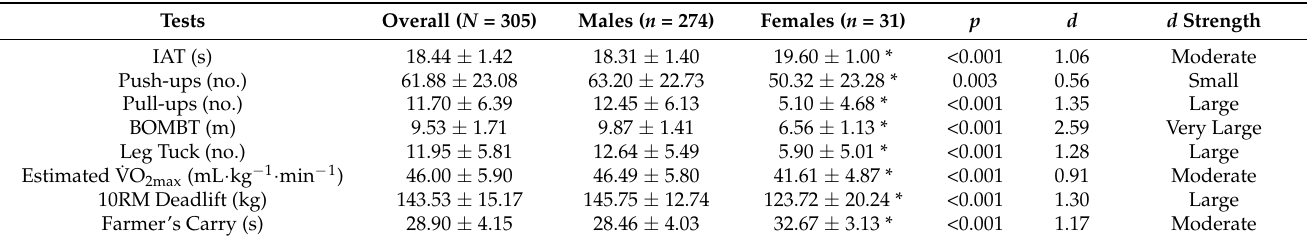
Table 1. Descriptive data (mean ± SD) for fitness test performance (Illinois agility test [IAT], metronome push-ups, pull-ups, 4.54 kg backwards overhead medicine ball throw [BOMBT], leg tuck, estimated maximal aerobic capacity [ ˙VO 2max ] from the 20 m multistage fitness test, 10RM deadlift, and the farmer’s carry) for firefighter trainees.